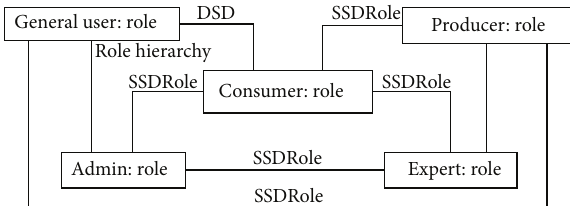
Figure 7: Object diagram for Extended RBAC security model in u-